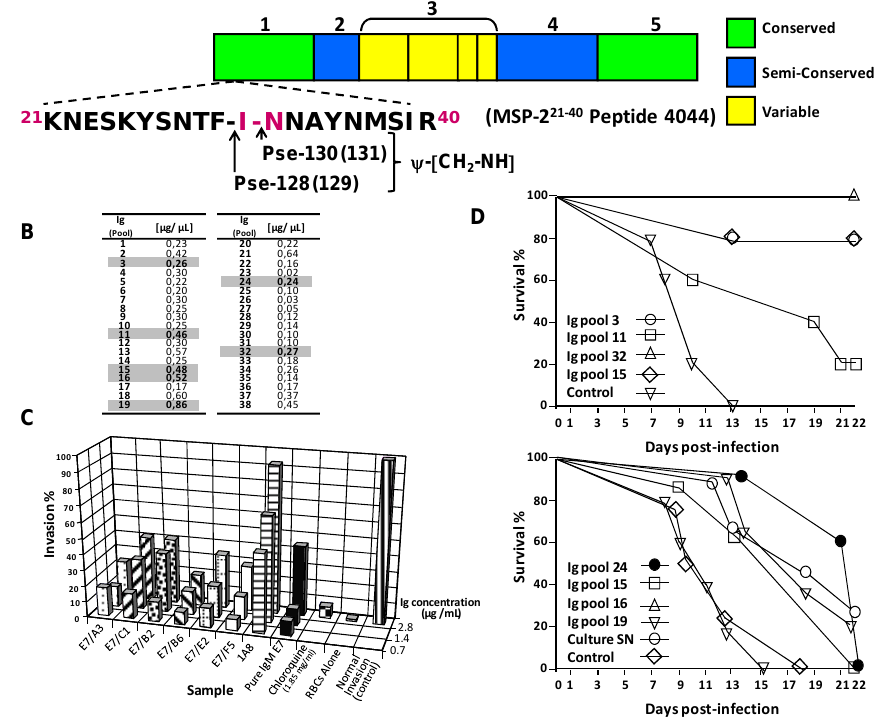
Figure 8. MSP-2 immunoglobulins passively transferred to BALB/c mice. A. Genetic organization of the MSP-2. B . Ig used for all experiments. C . in vitro malarial invasion inhibition experiments. D . Survival percentage by passive transfer of Ig and challenged with a dose of 5 × 10 3 iRBC (upper panel). Survival percentage by passive transfer of Ig and challenged with a dose of 2.5 × 10 4 iRBC with a Plasmodium berghei ANKA strain (lower